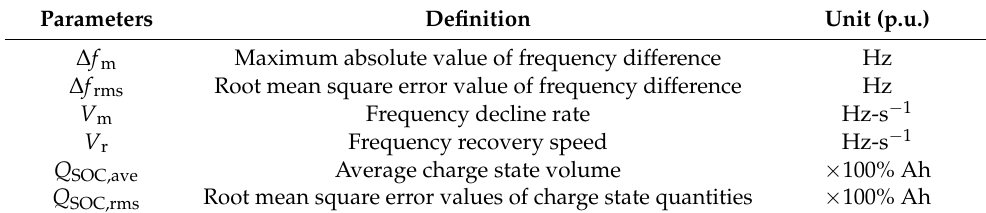
Table 4. System simulation parameters. Table 5. Evaluation indicator parameters (p.u.).